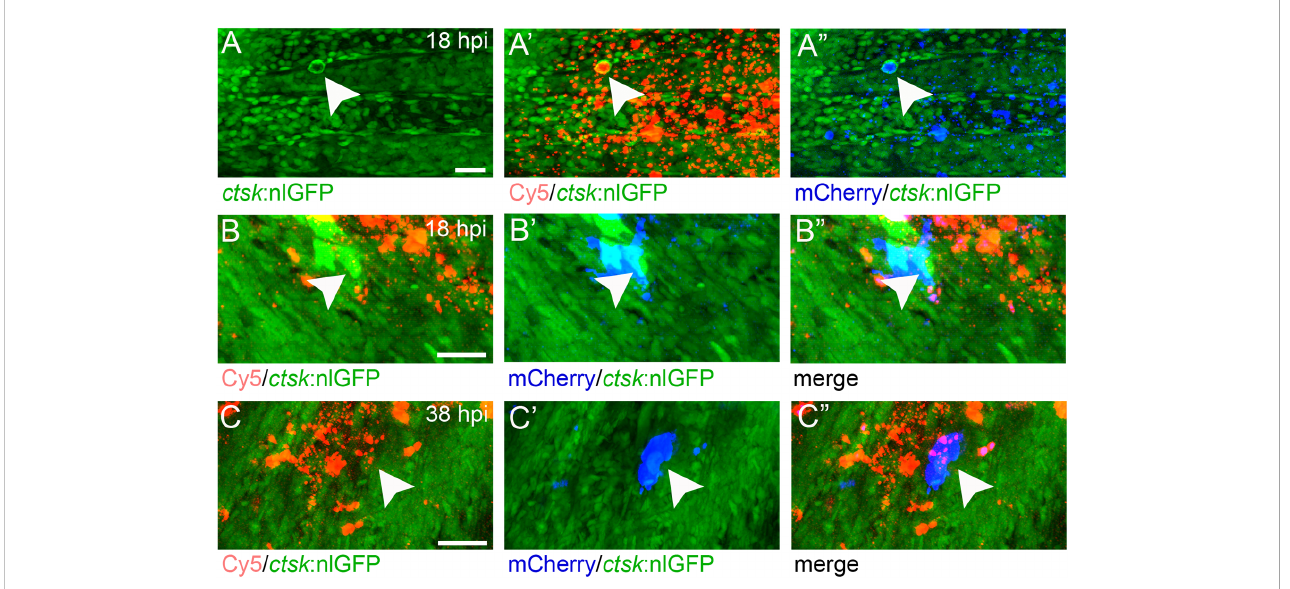
FIGURE 3 ctsk :nlGFP positive cells in the medaka caudal fi n internalize plasmid-functionalized CaP nanoparticles and express mCherry protein. (A, A ” ) Caudal fi n of ctsk :nlGFP transgenic medaka at 12 dpf and 18 hours after injection of CAP/PEI-Cy5/pDNA-mCherry/SiO2 nanoparticles into the fi n. Panels show ctsk : nlGFP positive cells (A) , colocalization of nlGFP and Cy5 (A ’ ) , and colocalization of nlGFP and plasmid-encoded mCherry (A ” ) ; arrowhead). (B, C ” ) Large and dynamic mCherry expressing cell (arrowheads) at 18 hpi (B, B ” ) and 38 hpi (C, C ” ) . Panels show nlGFP positive cells colocalized with Cy5 (B, C) , colocalization of nlGFP with plasmid-encoded mCherry (B ’ , C ’ ) and merge (B ” , C ” ) . Cy5 marks nanoparticles (red) and mCherry (blue) marks cells that took up nanoparticles and express reporter protein. 6 out of 10 analysed embryos showed this phenotype. Scale bars = 20 µm (A)